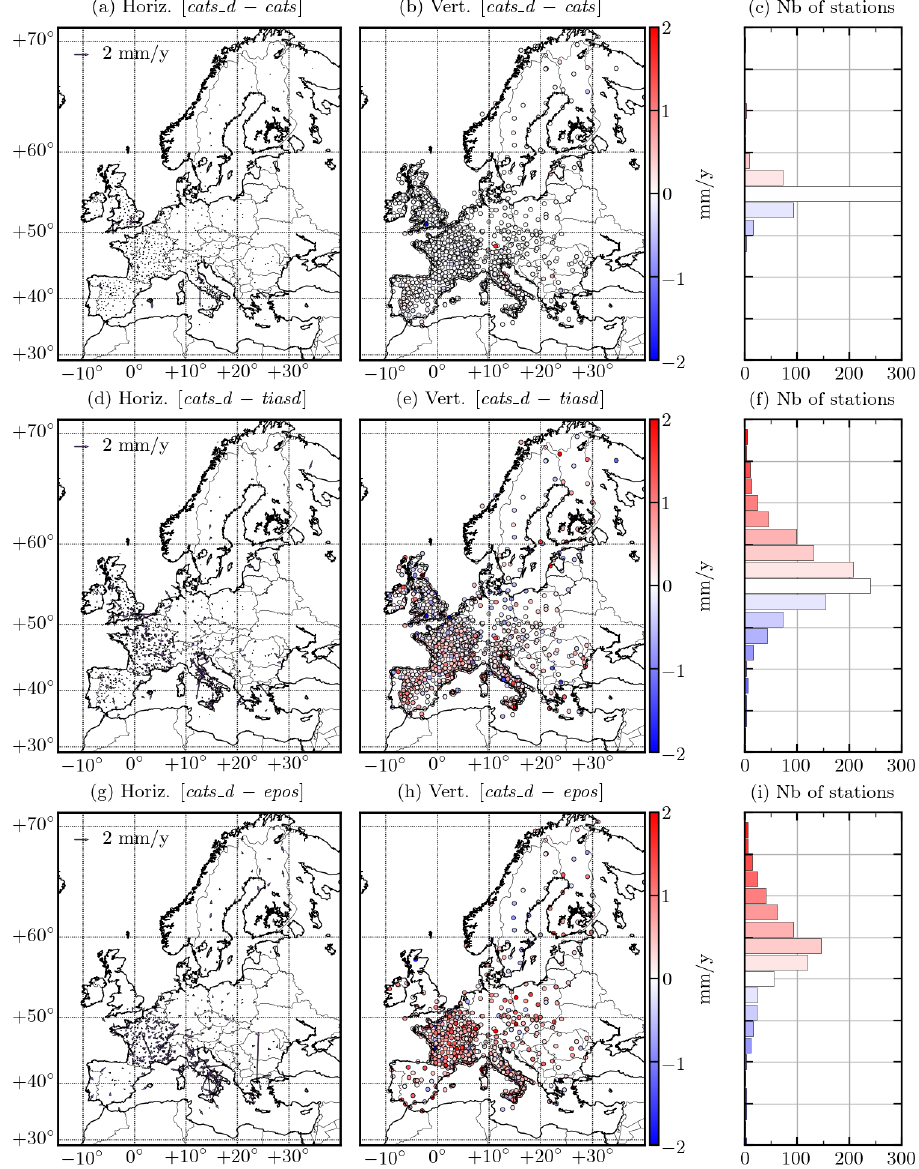
Figure 5. ( a , b ) Difference in velocity field between cats_d and cats . The panel ( c ) represents the number of stations where the vertical velocity was, respectively, overestimated (red) or underestimated (blue) by cats_d compared to cats . ( d – f ) are the same for the difference between cats_d and tiasd , and ( g – i ), between cats_d and the EPOS